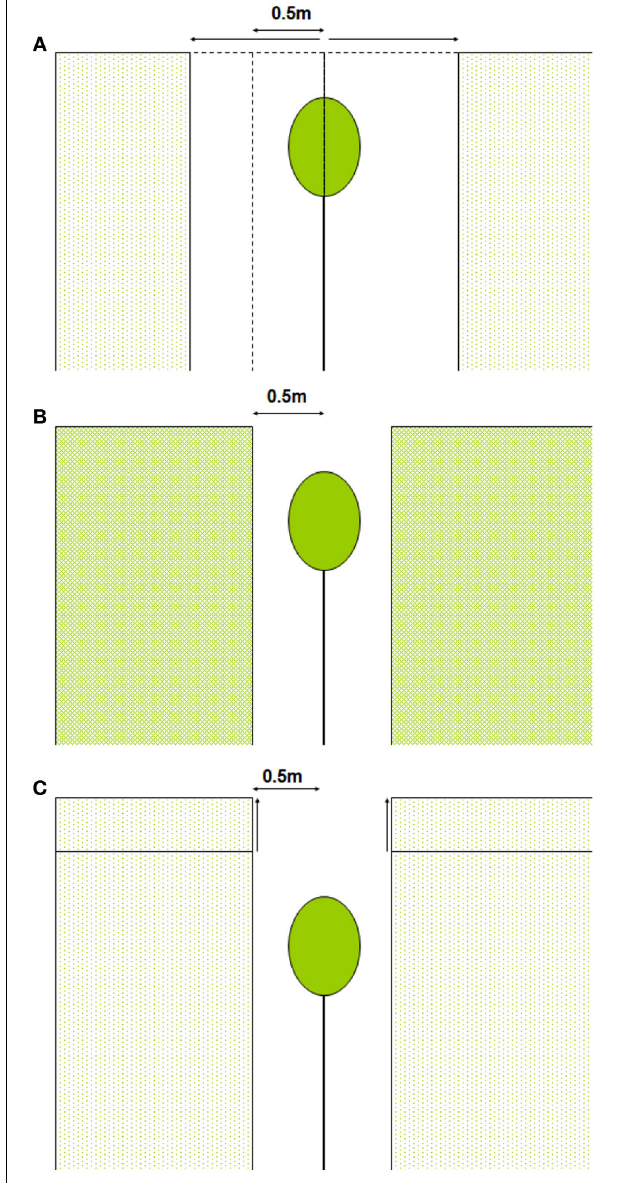
FIGURE 2 | (A–C) Schematic presentation of model simulations. In (A) vegetation is removed around the individual within a variable radius, in (B) the LAI of the surrounding vegetation is increased and in (C) the vegetation height is increased (leaf area density remains